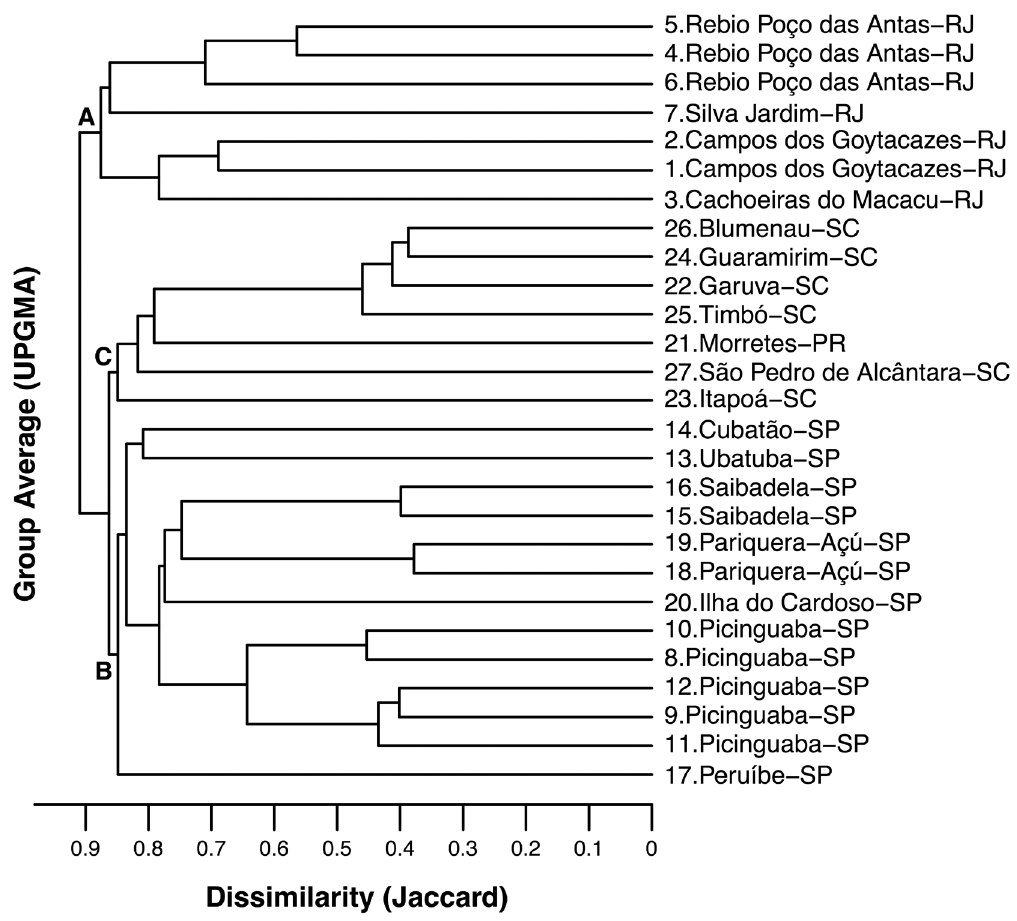
Figure 4 – Cluster analysis showing the floristic dissimilarity between the 27 sample areas distributed along the coastal region of the southeastern Atlantic Forest. A, group composed by the forests of Rio de Janeiro State (sample areas 1 to 7), in the north of the gradient; B, group composed by the forests of São Paulo (8 to 20), in the middle of the gradient; C, group composed by the forests of Paraná and Santa Catarina States (21 to 27), in the south of the